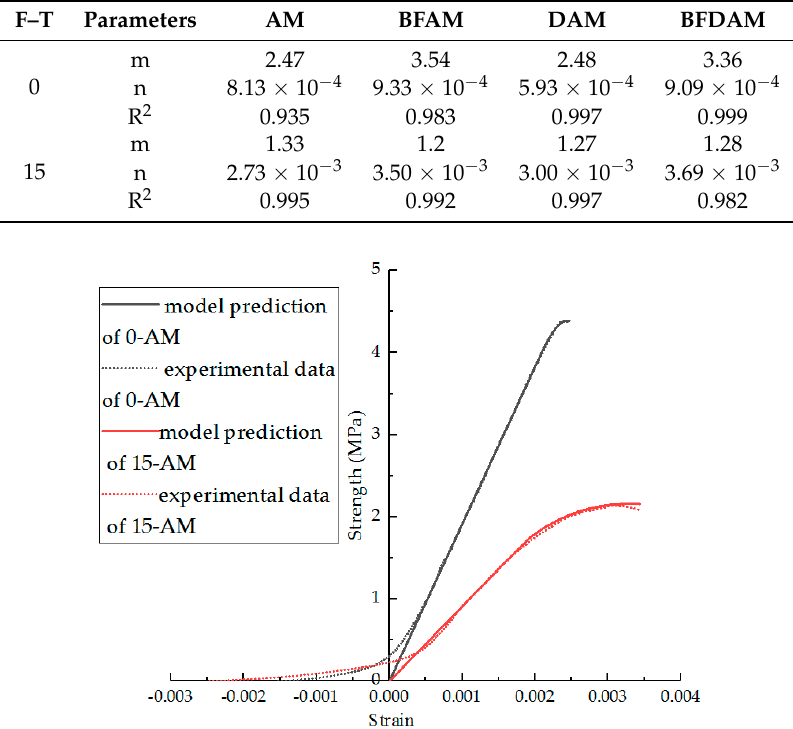
Figure 20. Comparison of experimental data and model predictions for AM under F–T cycles.